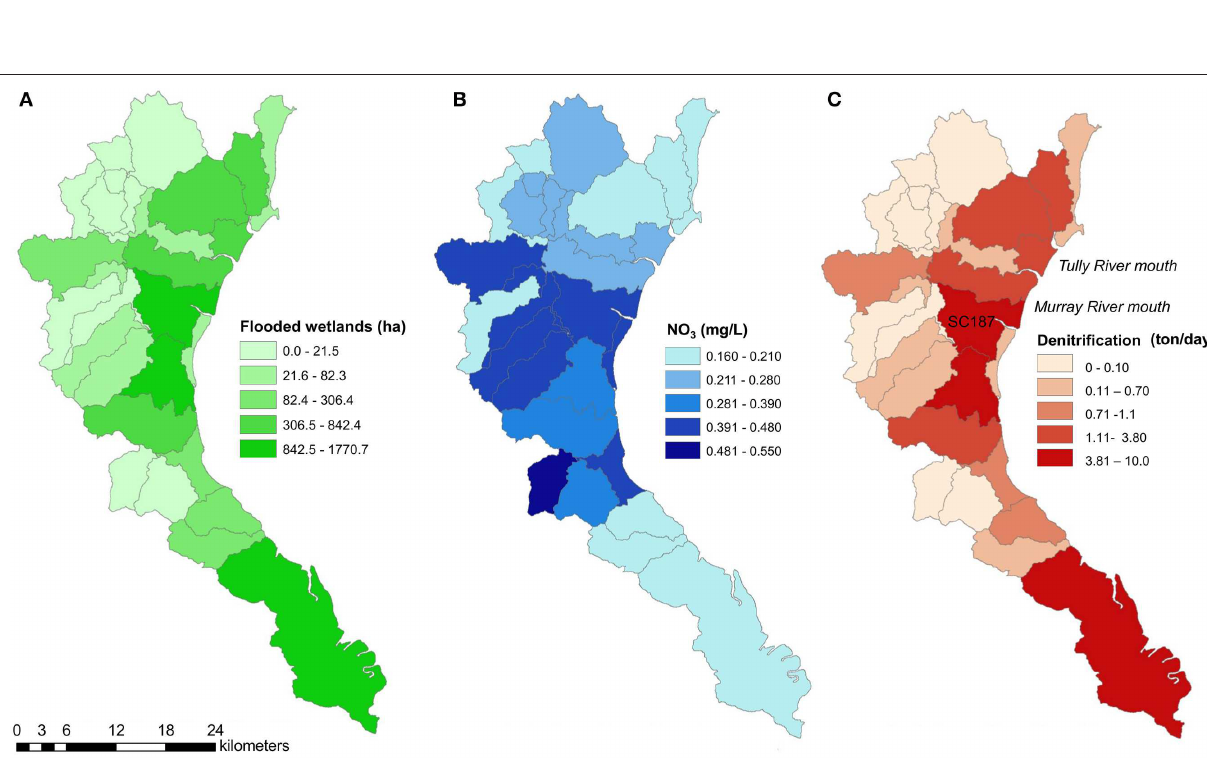
Frontiers in Marine Science |